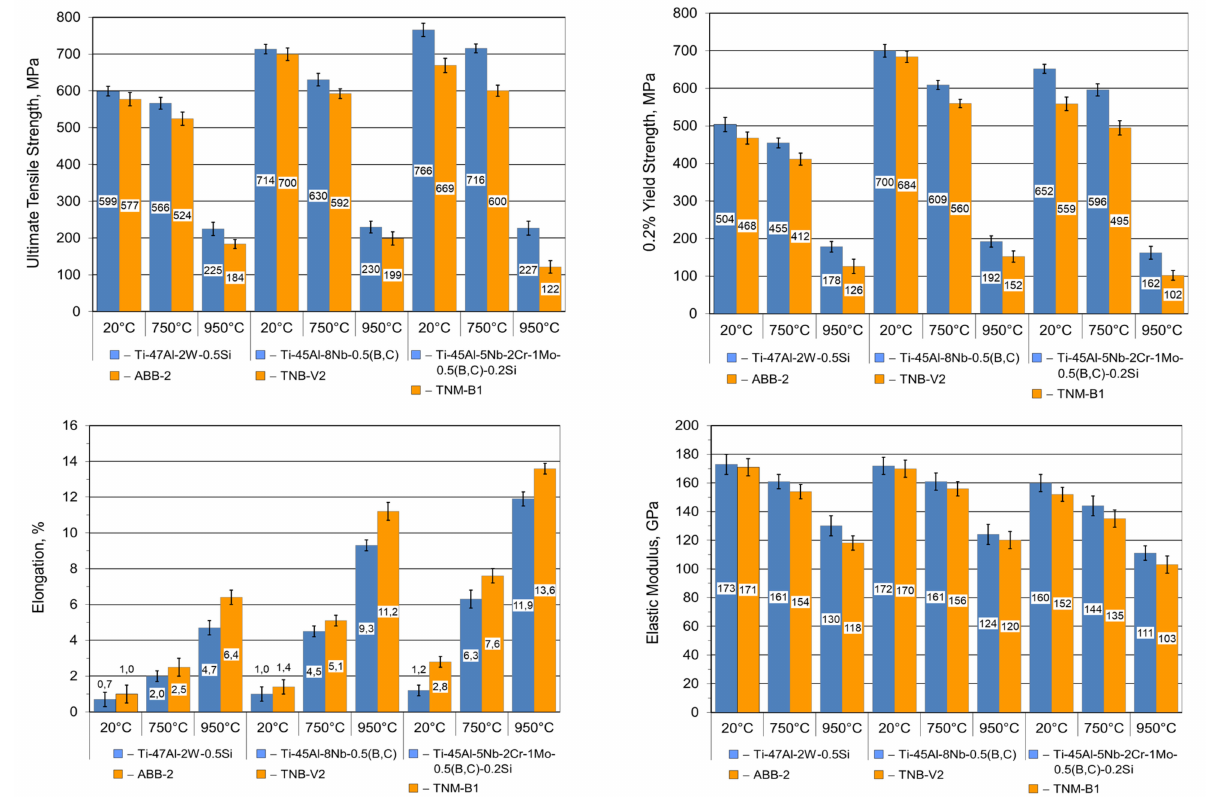
Figure 10. Ultimate tensile strength, 0.2% yield strength, elongation, and Young’s modulus of produced and reference alloys at temperature 20, 750, and 950 ◦